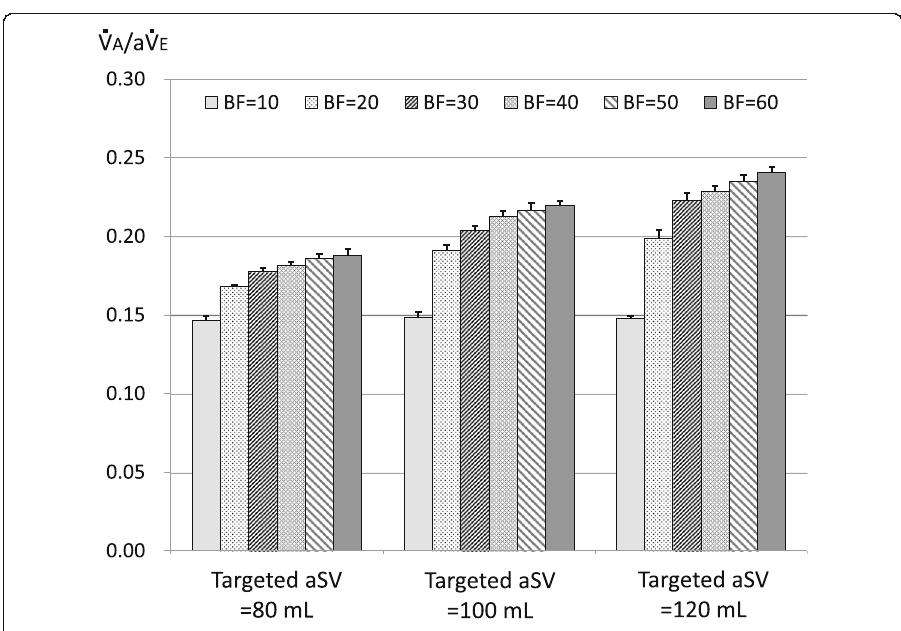
Fig. 7 Ventilation efficiency ( _ VA/a _ VE) measured with targeted actual stroke volume (aSV) of 80, 100, and 120 mL. Legend: Bar graph indicates mean _ VA/a _ VE ( n =5), and vertical bar indicates standard deviation. The results of statistical significance test are as follows: BF=10 vs BF=20 – 60: P <0.001 with all aSV; BF=20 vs BF=30 – 60: P <0.001 with all aSV; BF=30 vs BF=40: ns with aSV=80 and 120, P <0.01 with aSV=100; BF=30 vs BF=50: P <0.001 with aSV=80 and 100, P <0.01 with aSV=120; BF=30 vs BF=60: P <0.001 with all aSV; BF=40 vs BF=50: ns with all aSV; BF=40 vs BF=60: P <0.05 with aSV=80 and 100, P <0.01 with aSV=120; and BF=50 vs